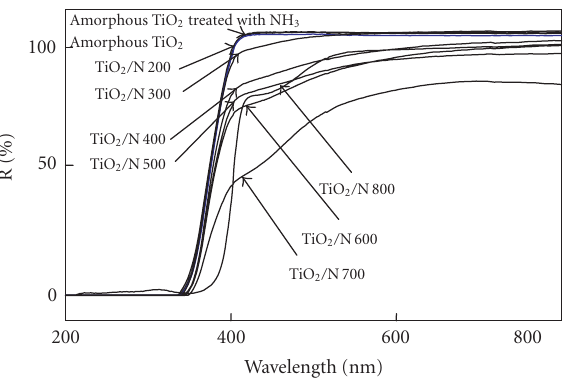
Figure 3: UV-VIS/DR reflection spectra of the TiO 2 and TiO 2 /N photocatalysts: amorphous TiO 2 treated with NH3aq and dried at 100 ◦ C; TiO 2 /N 200–TiO 2 /N 800 catalysts heated in the gaseous NH 3 atmosphere at temperatures 200–800 ◦ C,